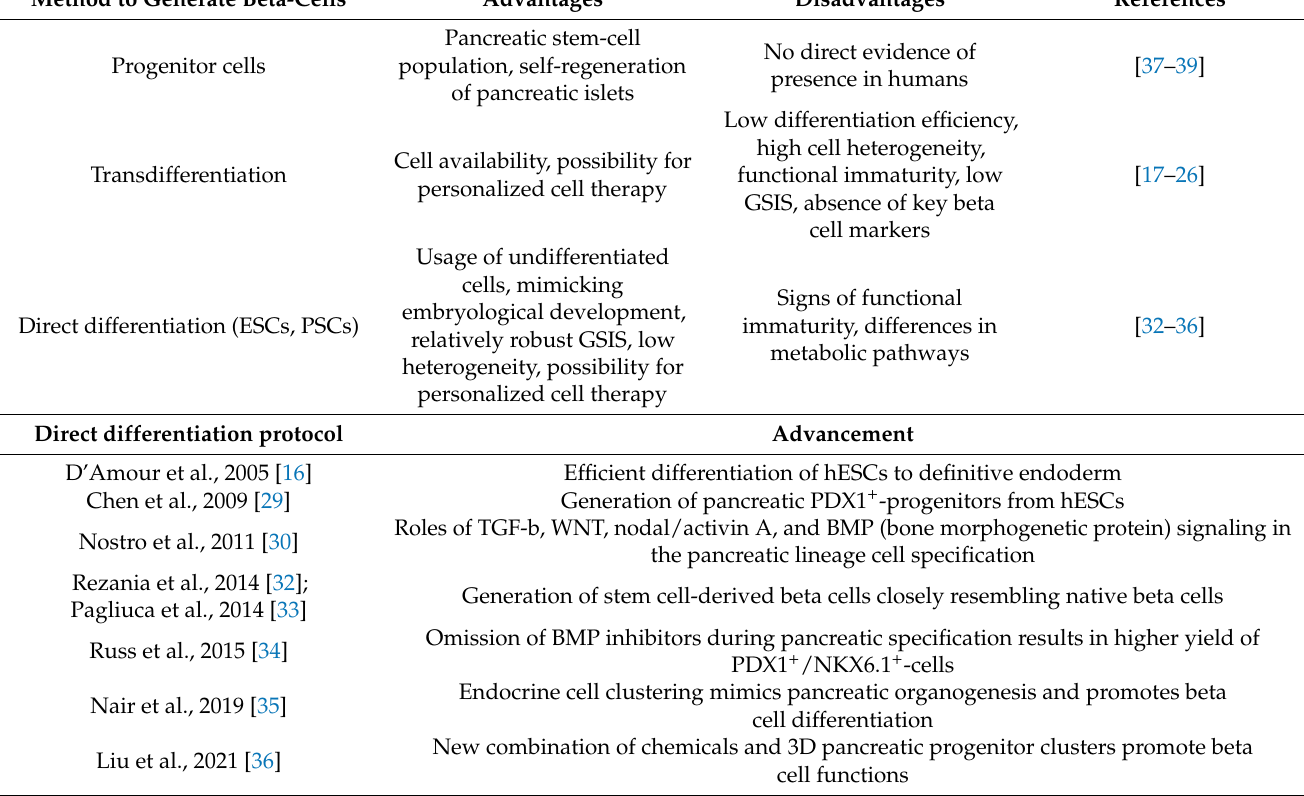
Table 1. Methods to generate beta cells from various cell sources. Direct differentiation